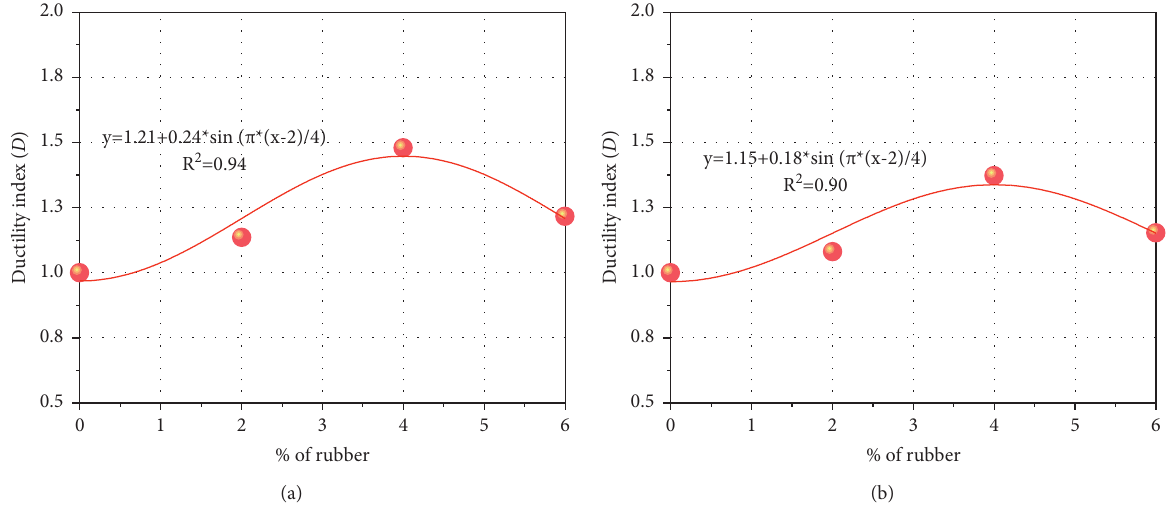
Figure 7: Relationship between the ductility index D and rubber content of cemented tailings for (a) 10% cement content samples and (b) 25% cement content samples.